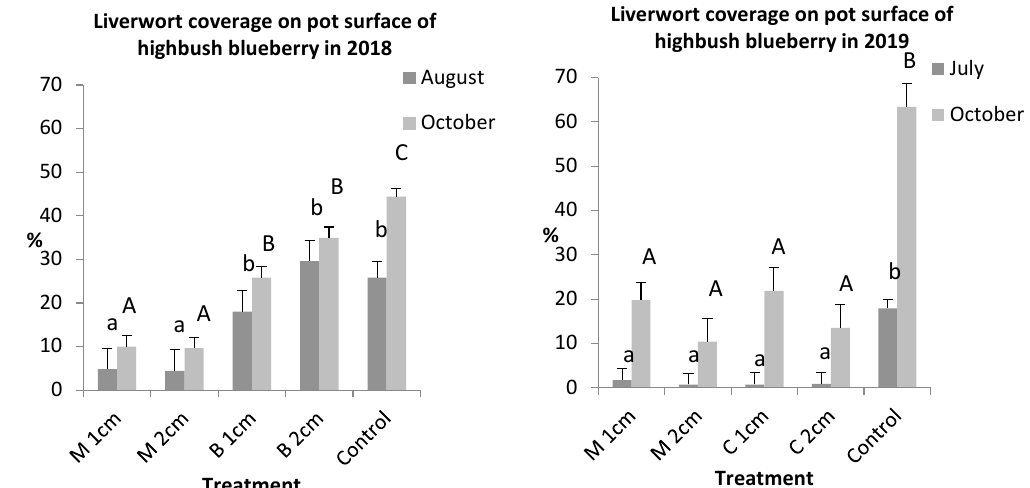
Fig. 2. Mean values and SE of liverwort coverage % on pot surface of highbush blueberry in different months, years and treatments. M, B and C correspond to different origins of Sphagnum moss, cm is depth of moss layer on the pot surface at potting. Different letters indicate statistical difference p≤0.05. Small letters indicate results in July or August, and big letters in October. Treatment n=30